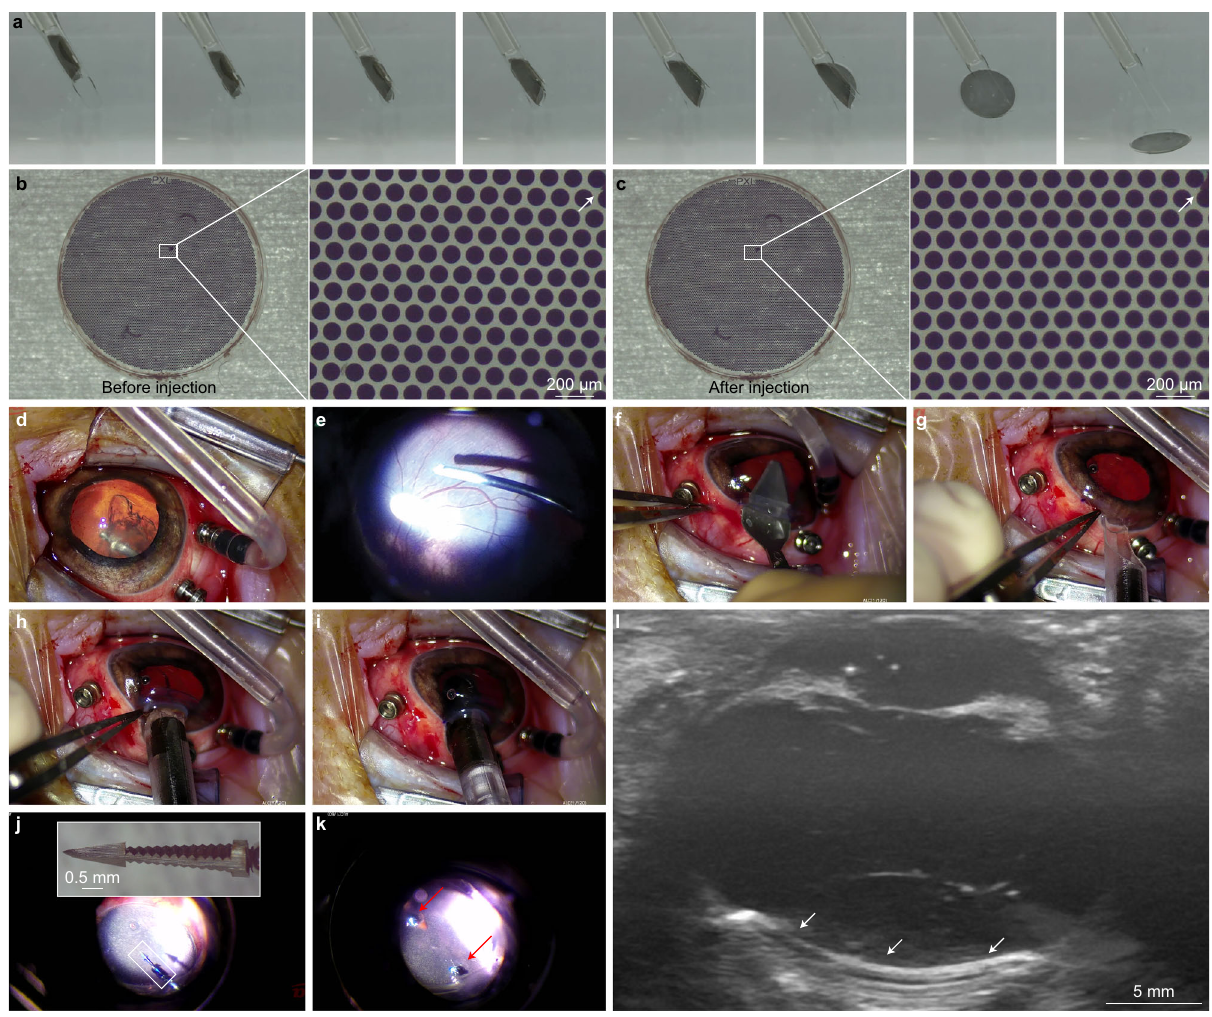
Fig. 6 Surgical injection of POLYRETINA. a Sequence of pictures showing POLYRETINA injection in saline (0.9% NaCl). When the implant is pushed towards the edge of the bevelled tube, the unfolding of the PDMS-based dome displaces the thin extensions that relieve the prosthesis. b , c POLYRETINA image before ( b ) and after ( c ) the injection procedure. The white arrows in the magni fi ed views indicate a mark on the pixel to con fi rm that the image is from the same area. The experiment was reproduced in three replicates. d – k , Sequence of pictures showing the main steps of the injection of POLYRETINA in a blind Göttingen minipig eye: vitrectomy ( d , e ), a corneal incision ( f ), POLYRETINA injection ( g – i ) and POLYRETINA fi xation with two retinal tacks ( j , k ). l Post-surgical echography of the implanted POLYRETINA (white arrows) showing its tight apposition to the retina. The experiment was reproduced in three replicates. Images in panels d – l are